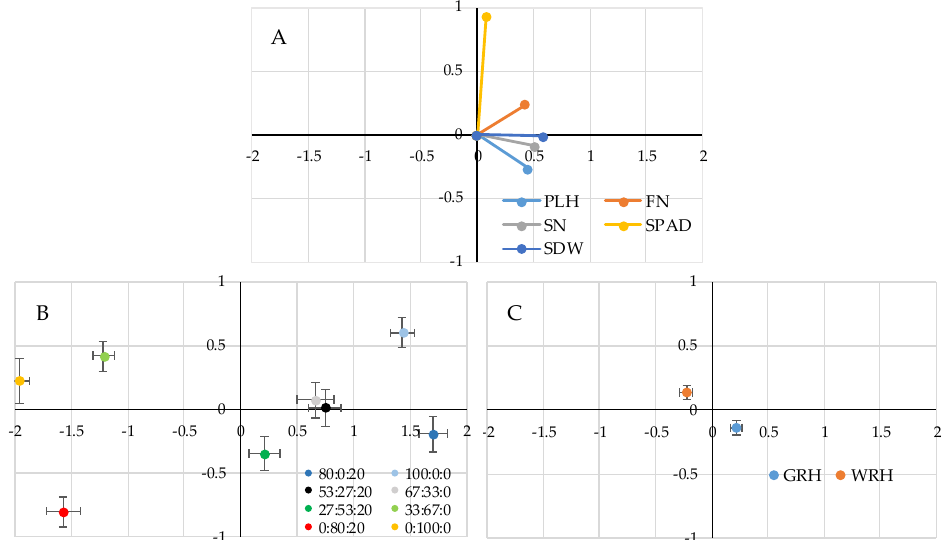
Figure 4. The plot ( A ) shows the weights for principal components of the analysis for the 5 parameters measured for each geranium plant. In the other plots, the centroids and their standard errors in the two dimensions for each classification factor are plotted. ( B ) classified using the P:RH:ADR ratio (% v:v:v); ( C ) whole or grinded RH (WGH and GRH, respectively) PLH, FN, SN, SPAD, and SDW = plant height, flower number, shoot number, SPAD value, and shoot dry weight, respectively.